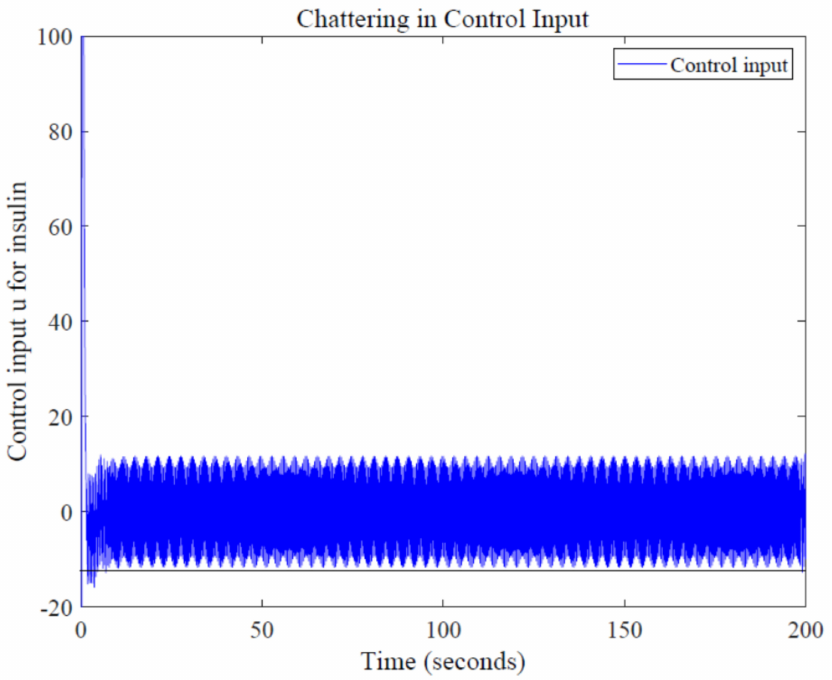
Figure 12. Chattering in control input